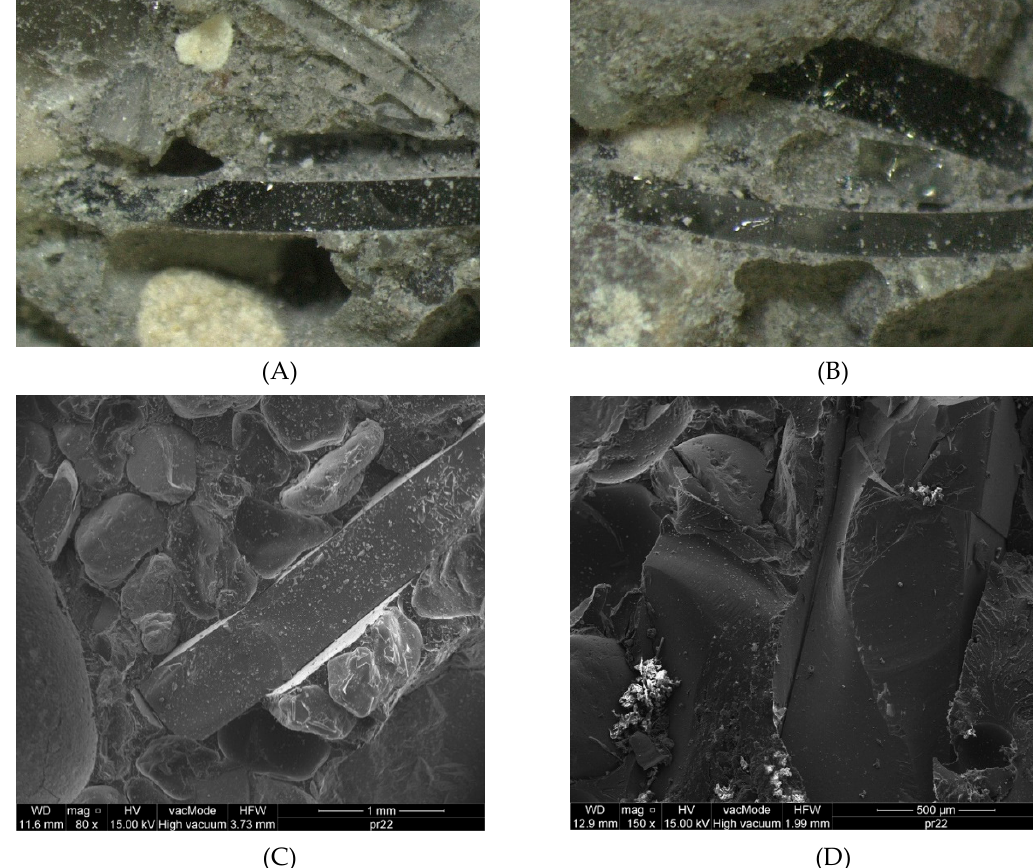
Figure 6. Two examples of grains of glass aggregate in leaven and air voids located in their close vicinity. Magnification: ( A , B ) 10x; ( C ) 80x; ( D ) 150x.